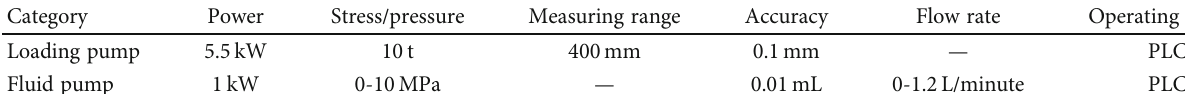
Table 1: Key technical parameters of the